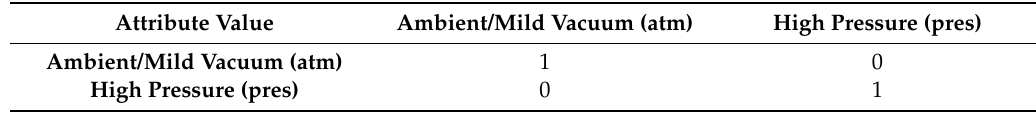
Table 3. Binary similarity table for the attribute Pressure